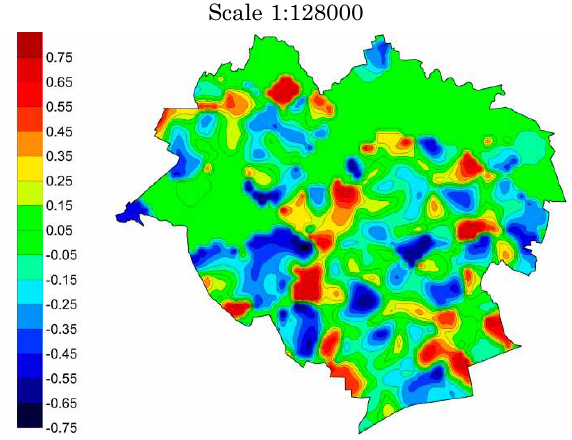
Fig. 6. Map of market transaction number change dynamics Source : own study.